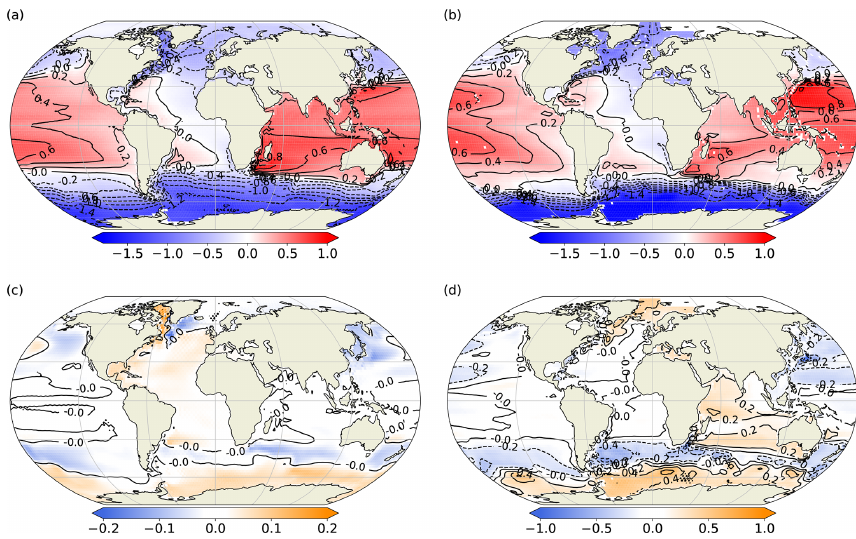
Figure 9. Time mean (years 2001–2025) of SSH (m) for (a) FORTE 2.0 L35 and (b) OCCA (2004–2006) climatology. Differences in SSH for (c) L20–L35 and (d) L35–OCCA.